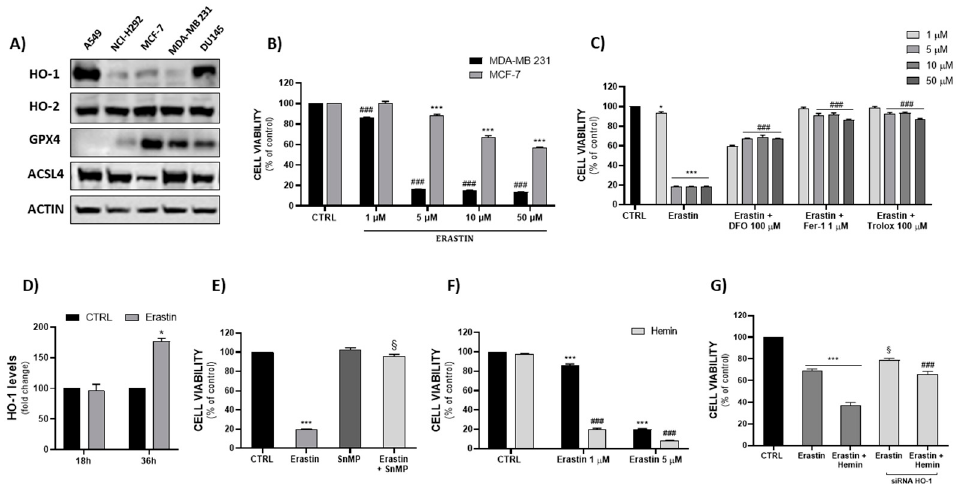
Figure 1. ( A ) Basal protein expression screening of HO-1, HO-2, GPX4 and ACSL4 in A549,